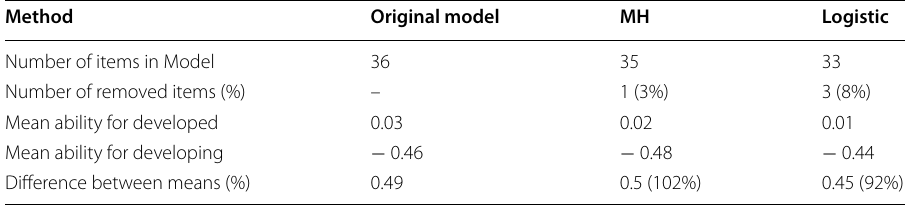
Table 5 DIF methods on the course